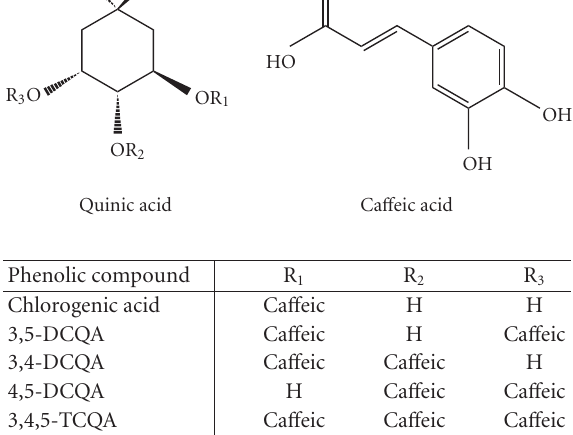
Figure 3. Molecular structures of phenolic compounds in the PL cell line generated from the purple-fleshed sweet potato, cv